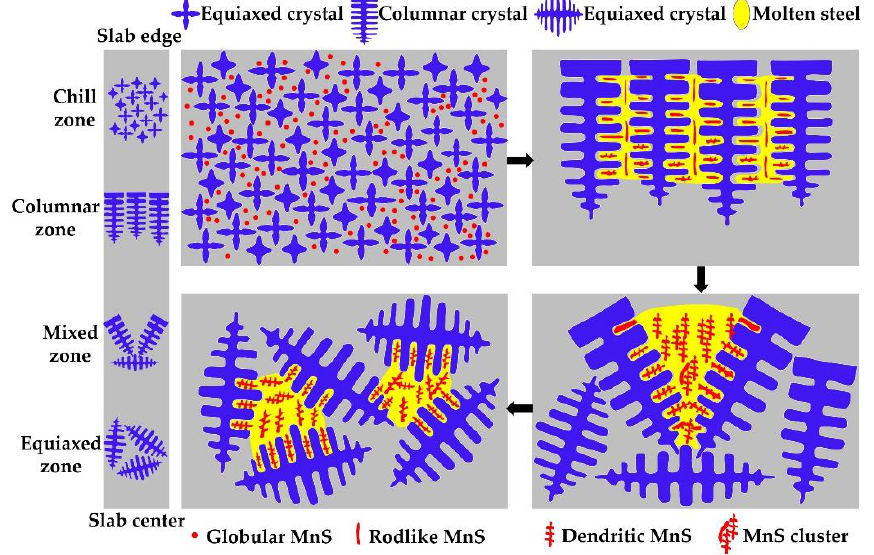
Figure 11. Schematic drawing of MnS inclusion aggregation mechanism along the slab thickness of the medium carbon 45# steel.